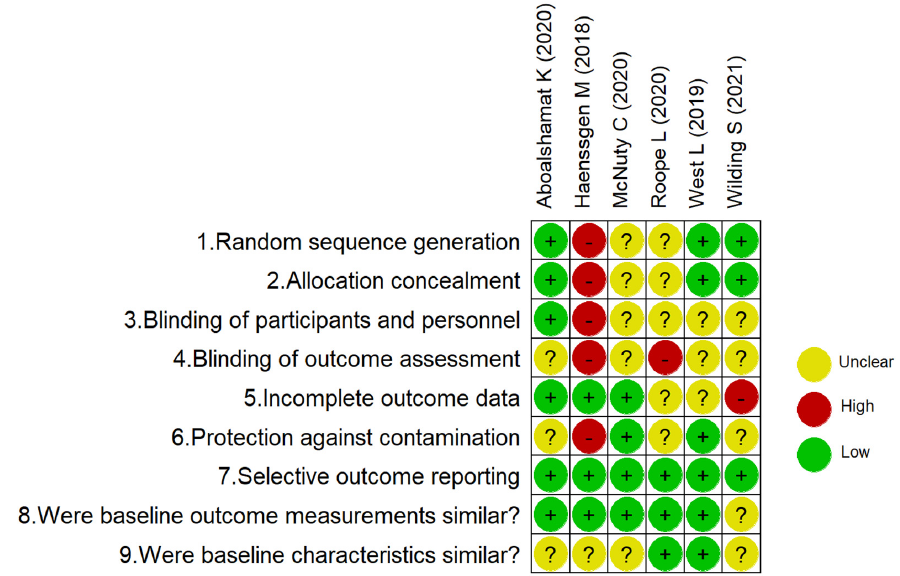
Figure 2 . Risk of bias for studies with a separate control group . Figure 2. Risk of bias for studies with a separate control group.